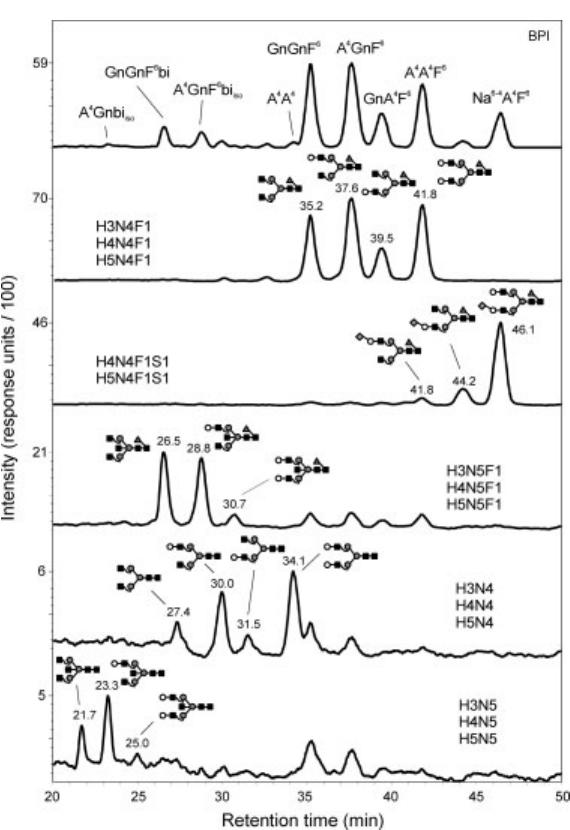
Figure 10. PGCC-MS analysis of IgG. The upper trace shows the BPI chromatogram of a sample of reduced N -glycans from hu- man polyclonal IgG subjected to PGC separation with MS detec- tion. The following lines are SIM chromatograms showing the intensity of the doubly charged ions for distinct groups of N -gly- cans. The lettering indicates the numbers of hexoses, N -acet- ylhexoses, fucoses, and sialic acids (H, N, F, and S, respectively) comprised by the SIM masses. The cartoons depict the real structure of the glycans in each peak. The relativeintensity can be estimated from the y -axis